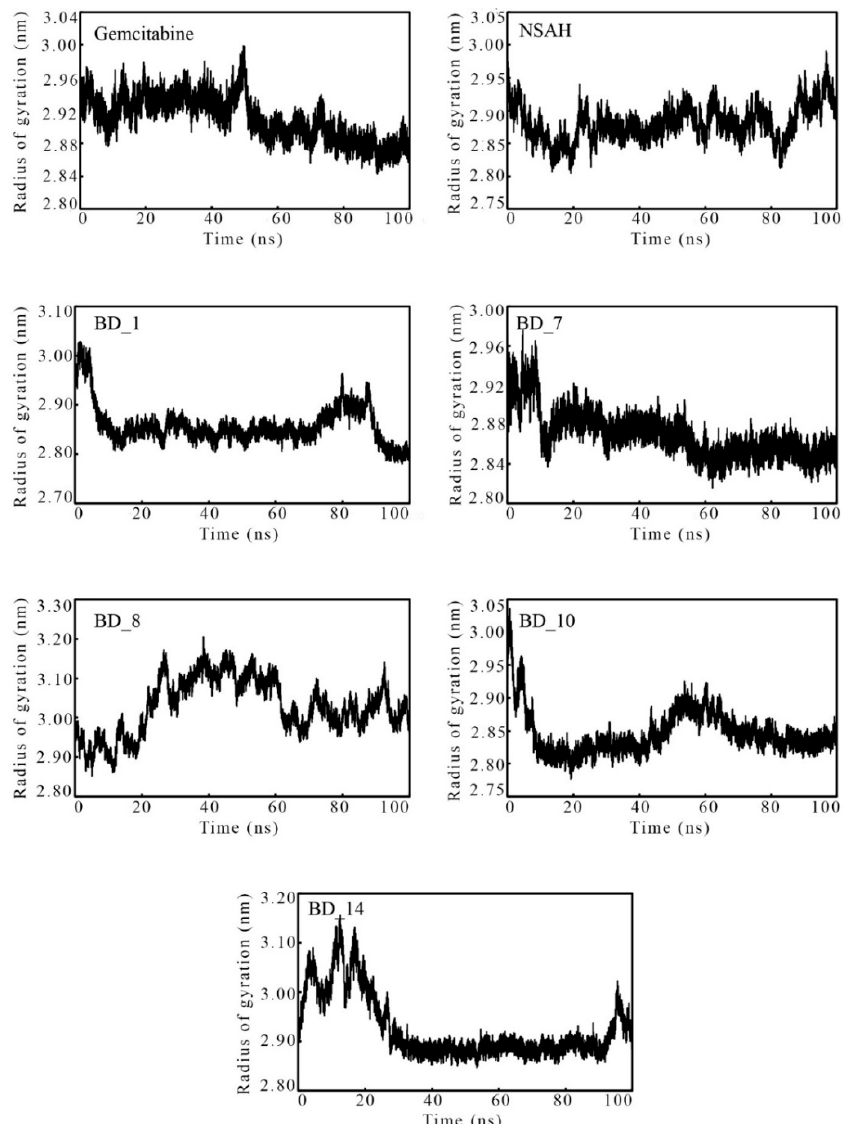
Figure 9. Radius of gyration against the time of the simulation of hRRM1 bound with gemcitabine, NSAH, BD_1, BD_7, BD_8, BD_10, and BD_14.